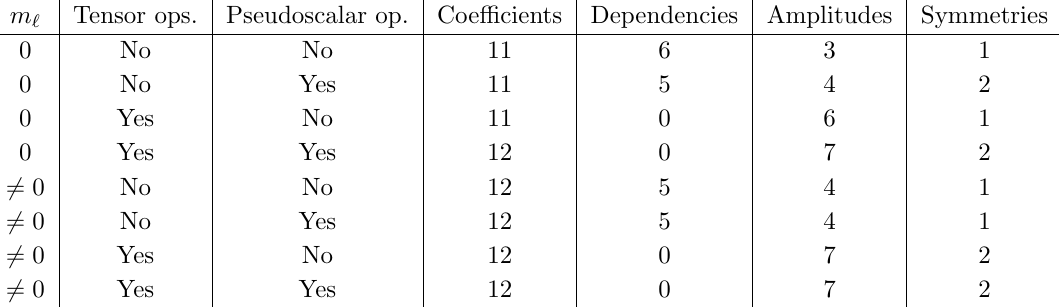
Table 1. Symmetries and dependencies among the B ! D (cid:3) ‘(cid:23) angular observables depending on the mass of the lepton and the contribution of tensor and pseudoscalar